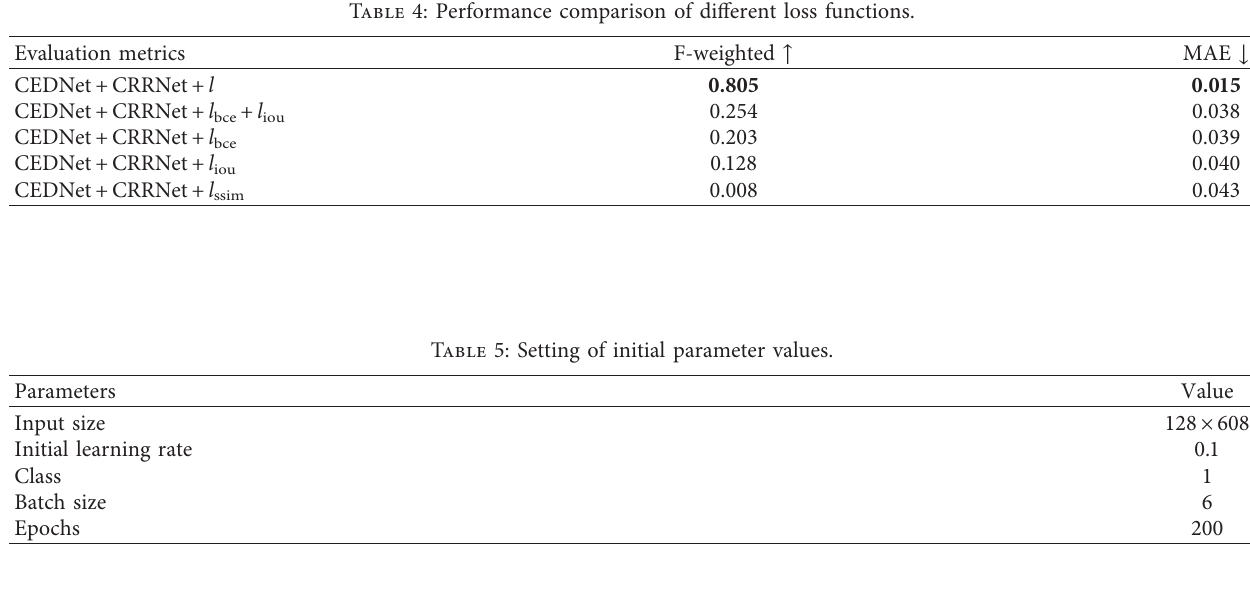
+ l . (e) l . (f) l . (g) l . bce iou bce iou ssim